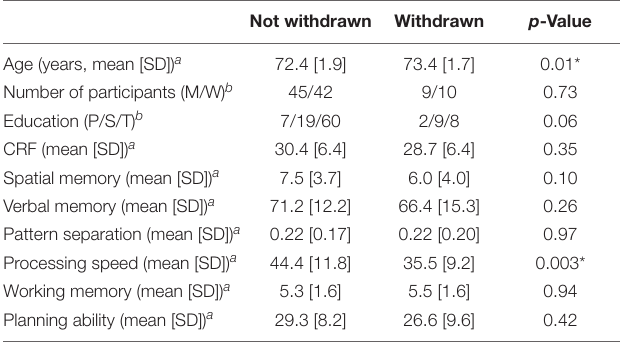
TABLE 1 | Baseline differences between participants who remained in the study for the entire duration and those who withdrew from the study. Not withdrawn Withdrawn p